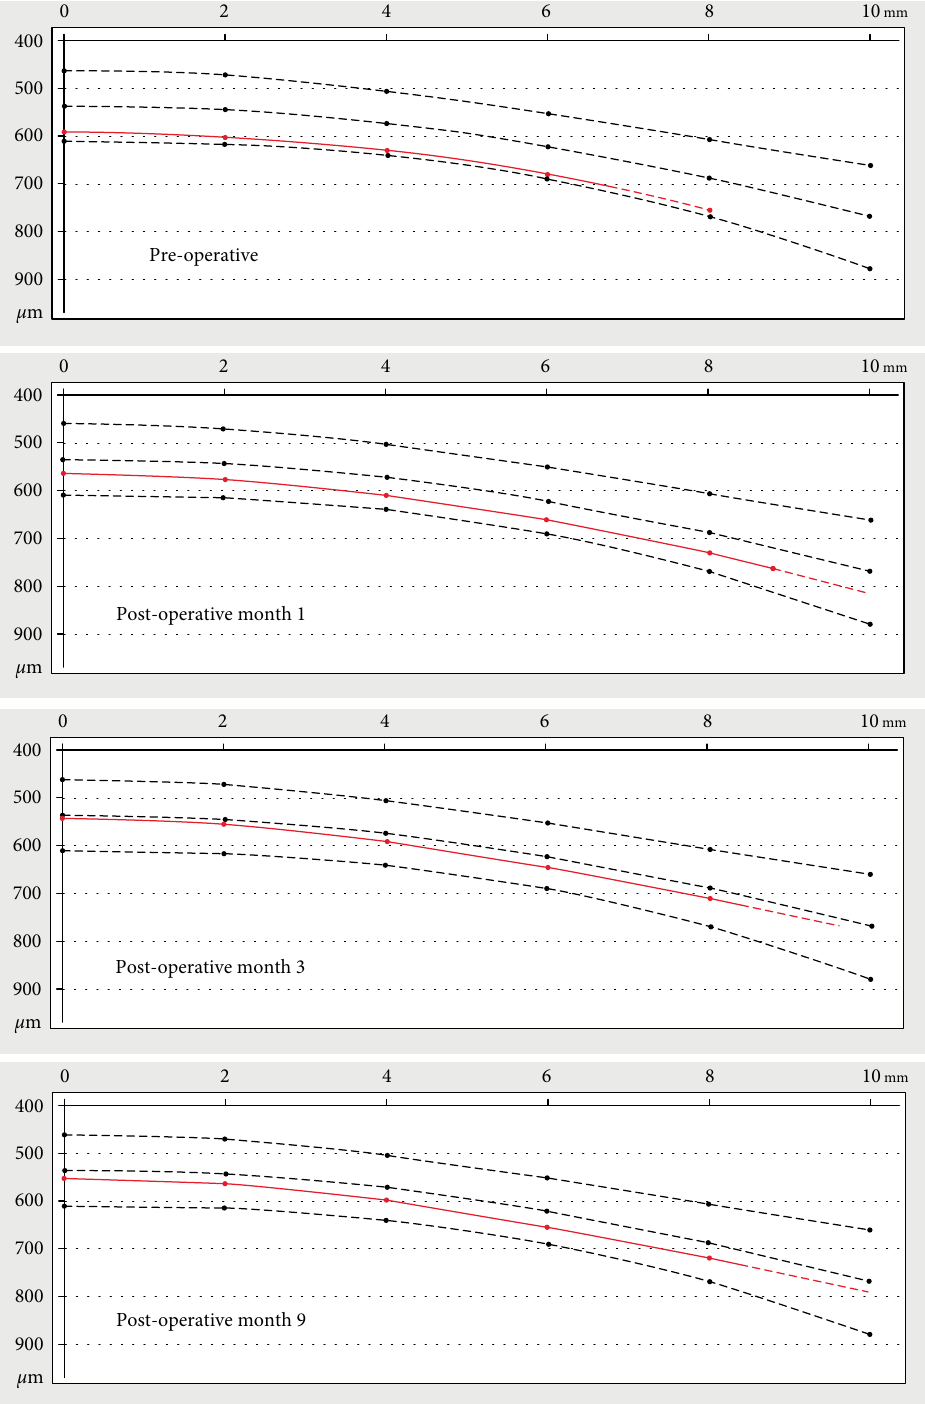
Figure 4: Corneal thickness spatial profile pre-and post-DSO for the left eye. The corneal thickness decrease following DSO is not limited to the central area of stripping but also extends to the peripheral